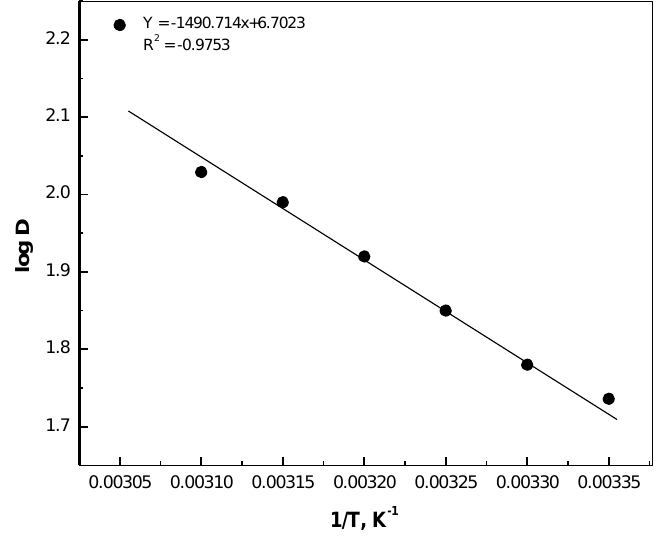
Fig. 5. Plot of log D vs 1/T for copper extraction, Conditions: 15% (v/v) furfuryl thioalcohol in kerosene, pH= 5.5, Na 2 SO 4 = 0.5 mol L -1 , O/A = 1, equilibrium time =10